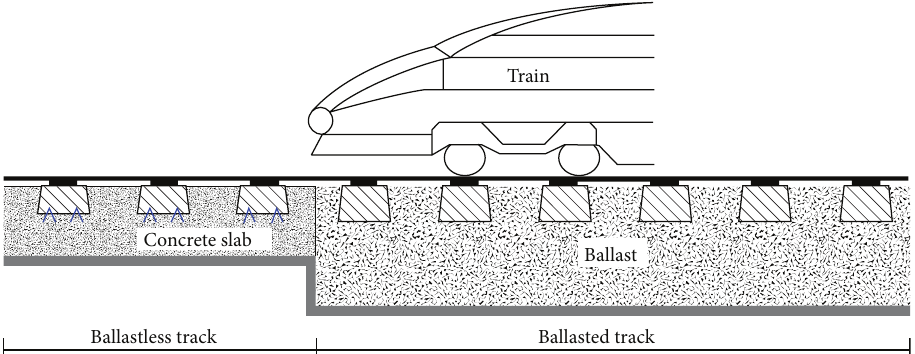
Figure 1: A schematic layout of the railway ballastless-ballasted